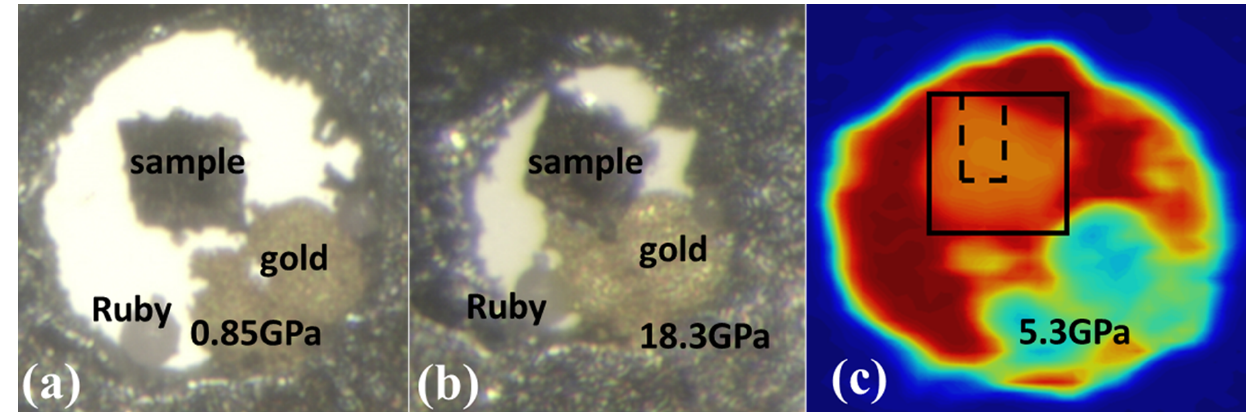
Figure 4. Optical images of the sample in DACs before ( a ) and after ( b ) in situ Laue diffraction measurements. Absorption scan across the sample ( c ). Black rectangle denotes the Laue diffraction scan area, and dotted line outlines the local scan area—which is explained further in the text. Size of the Laue diffraction scan area is 50 × 50 µm 2 .